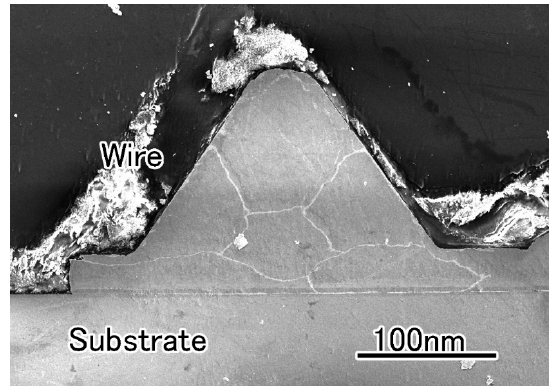
Figure 4. Cross-section of the welded wire cut perpendicular to the wire direction.